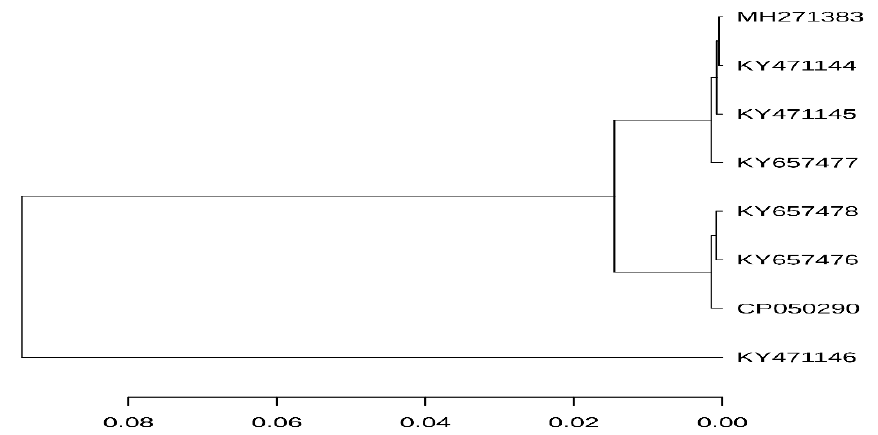
Figure 2. ANI analysis was performed using the ANI-blast method implemented in PYANI (v.0.2.9) and the tree was generated based on the ANI values. The horizontal lines represent the 95% threshold value. The scale bar represents sequence divergence. Detailed information on the plasmids source is summarized in Table 1.